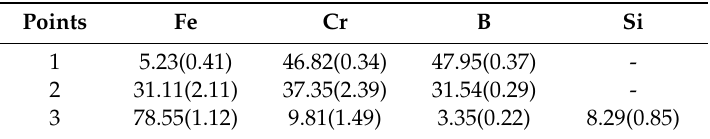
Table 1. The EPMA results of the selected region marked in Figure 2 (in at.%, standard deviation given in parentheses).